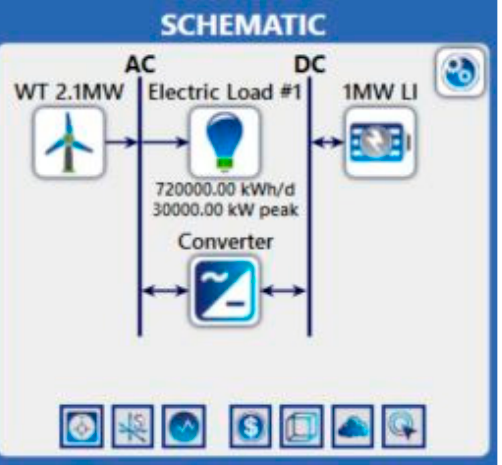
Figure 8. Topology of the wind/BESS system of the CDV Wind Complex simulated in HOMER Pro. As wind generation is associated with the dispatch of reserve energy from the trans- mission system, it sometimes has its limitations in inserting energy into the substation. However, the production capacity often exceeds the required energy, making the rest of the generation wasted. This operation is observed in Figure 9. It can be seen that the excess energy can be used to increase the efficiency of the wind farm, reducing energy losses. The solution is to insert the BESS to load with the surplus generated and unload when energy is requested from the wind farm by the energy transmission system. By doing this, the BESS may provide energy to complement the power of a turbine with a low generation or maintenance period. The result of this action is an increase in the efficiency of the wind complex and a reduction in the wind farm punishments with fines for providing less energy than required. In the simulated case, the SoC of the battery follows the wind energy production, as seen in Figure 10. During power reduction, the SoC is reduced, as the BESS acts to provide energy to the bus and returns to SoC = 100% when the power increases enough to inject into the grid and recharge the